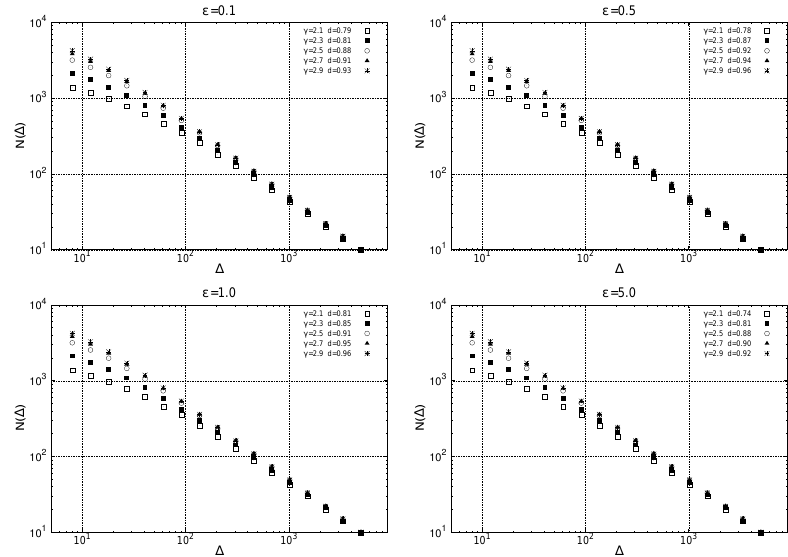
Figure 4. Number of N((cid:49)) intervals of (cid:49) length, which contain at least one inversion.